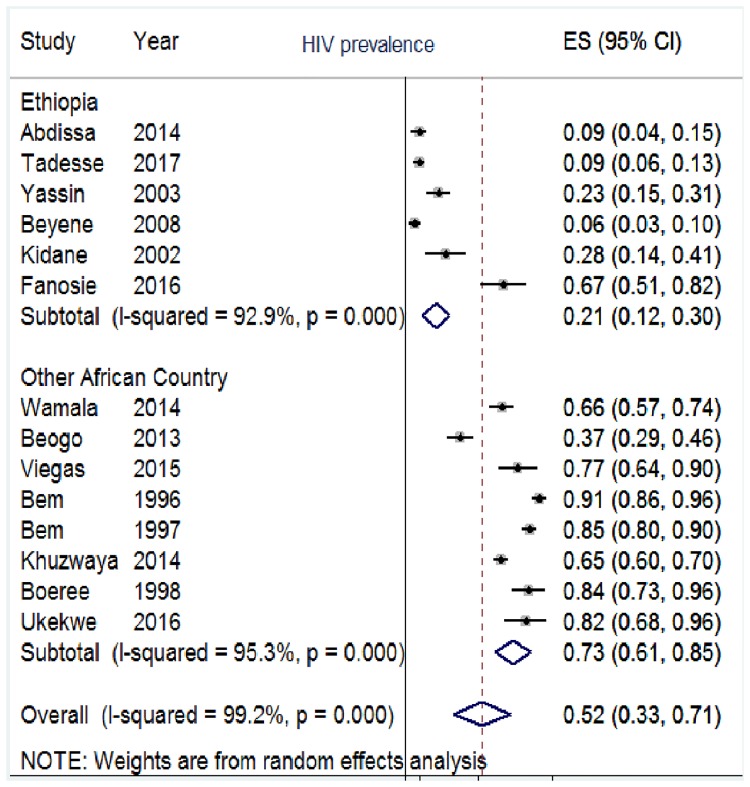
Proportion of TBLN/HIV co-infection among TBLN cases, Africa 1970–2015.